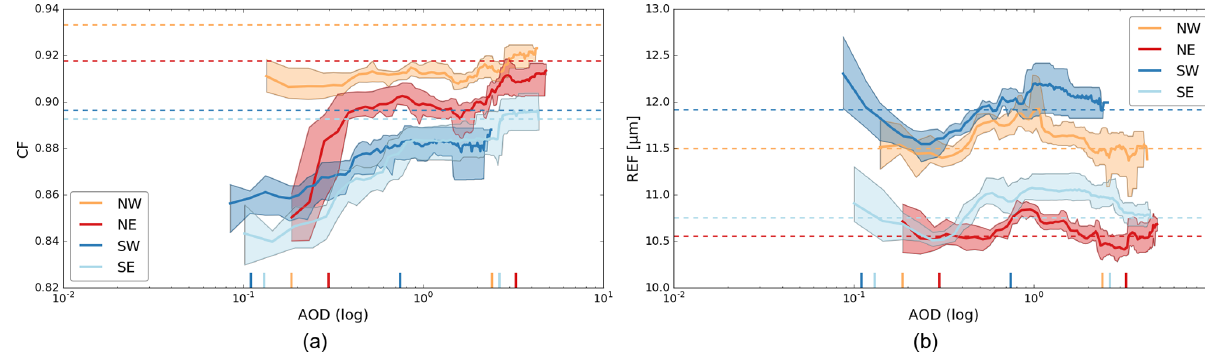
Figure 6. Mean partial dependence of CF (a) and REF (b) on AOD in the four subregions (colors) during JAS. Description as in Fig.